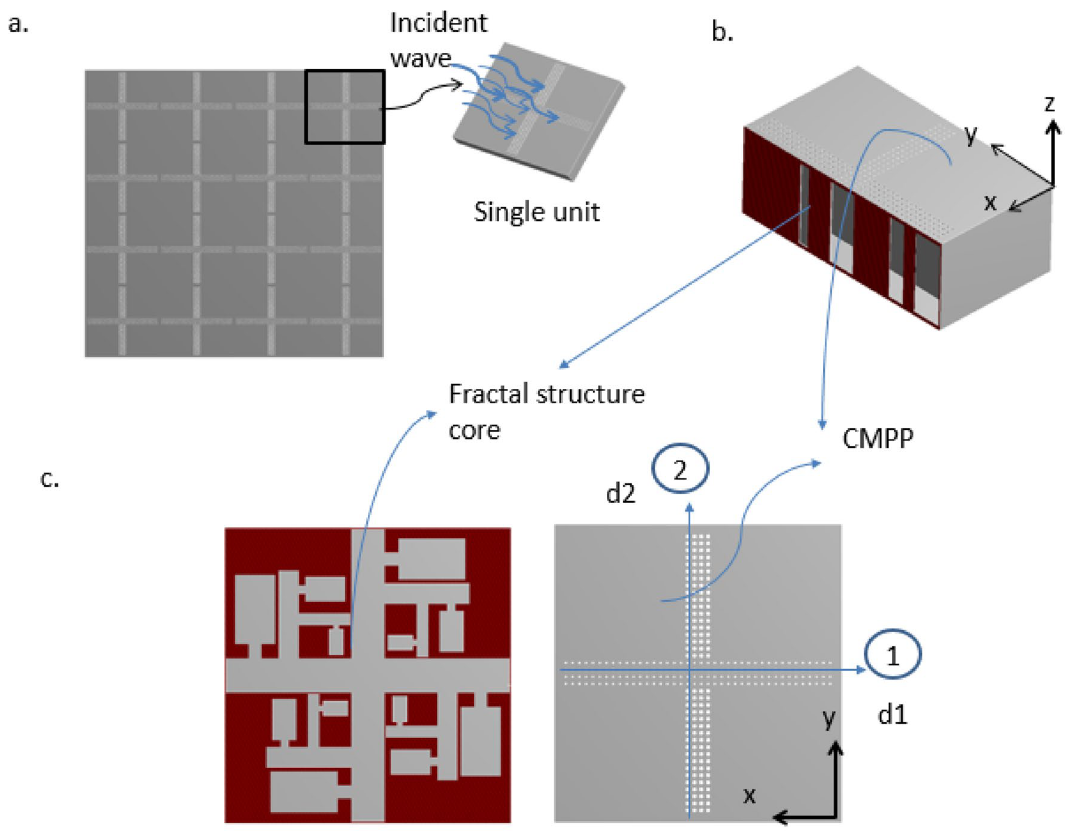
Figure 1. ( a ) Schematic of cross perforated fractal structure hybrid metamaterials panel composed of a cross- micro-perforated top face-sheet, a Helmholtz swastika fractals structure as core, and a back plate as bottom face- sheet. ( b ) One unit cell, sidewall cut-off vertically to see details inside. ( c ) CMPP with different perforation sizes in direction one having perforation diameter d1 and direction two is d2 and the back fractals cavity. Courtesy (ANSYS 17.0 45